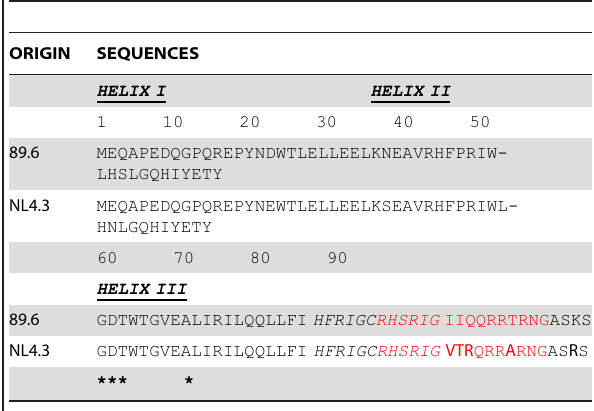
Table 1. Sequence alignment of Vpr proteins from two different origins.